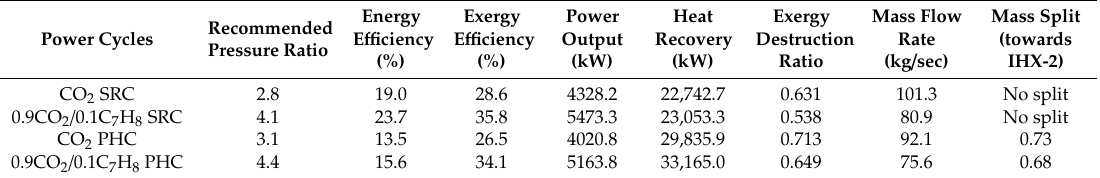
Table 6. Thermodynamic performance indicators at recommended pressure ratios for all four bottoming power cycles.